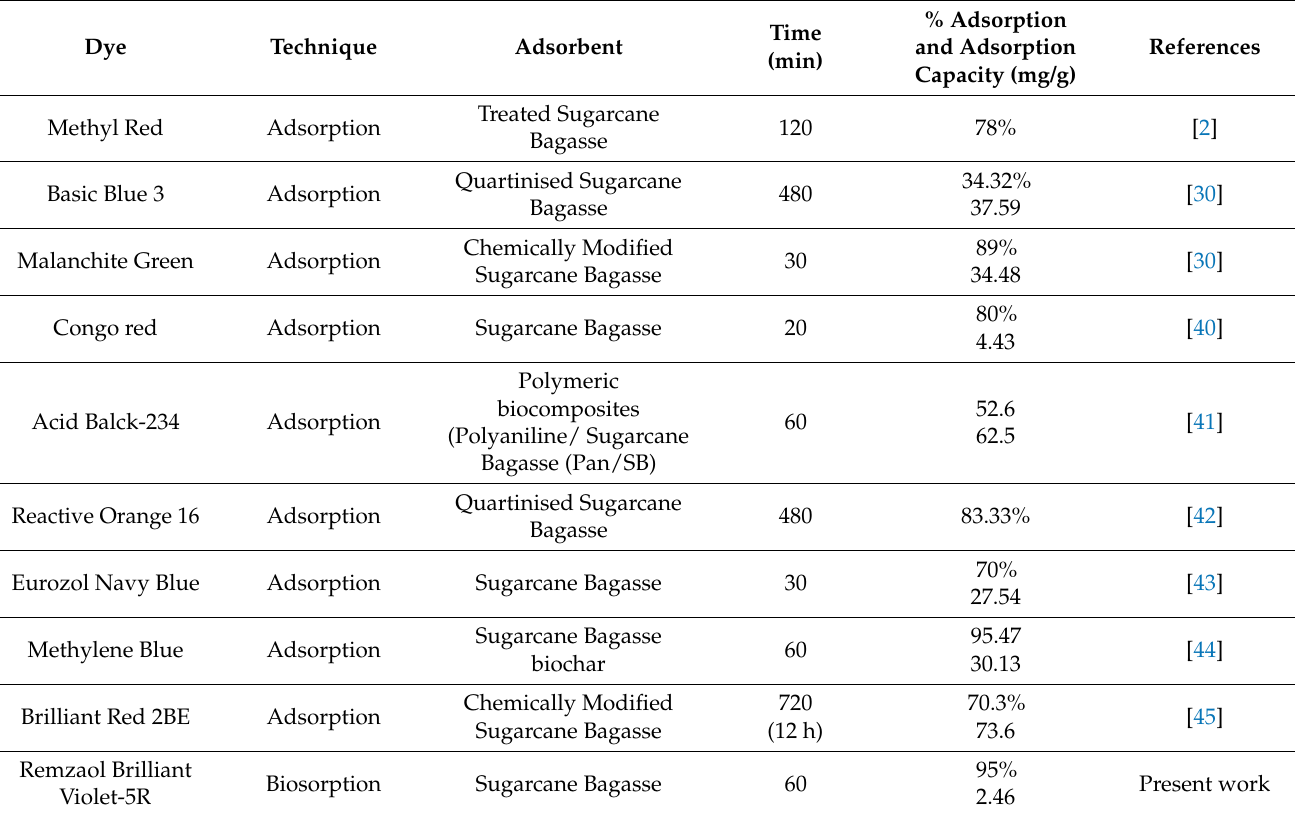
Table 3. Comparative analysis of the adsorption capacity of SCB for different